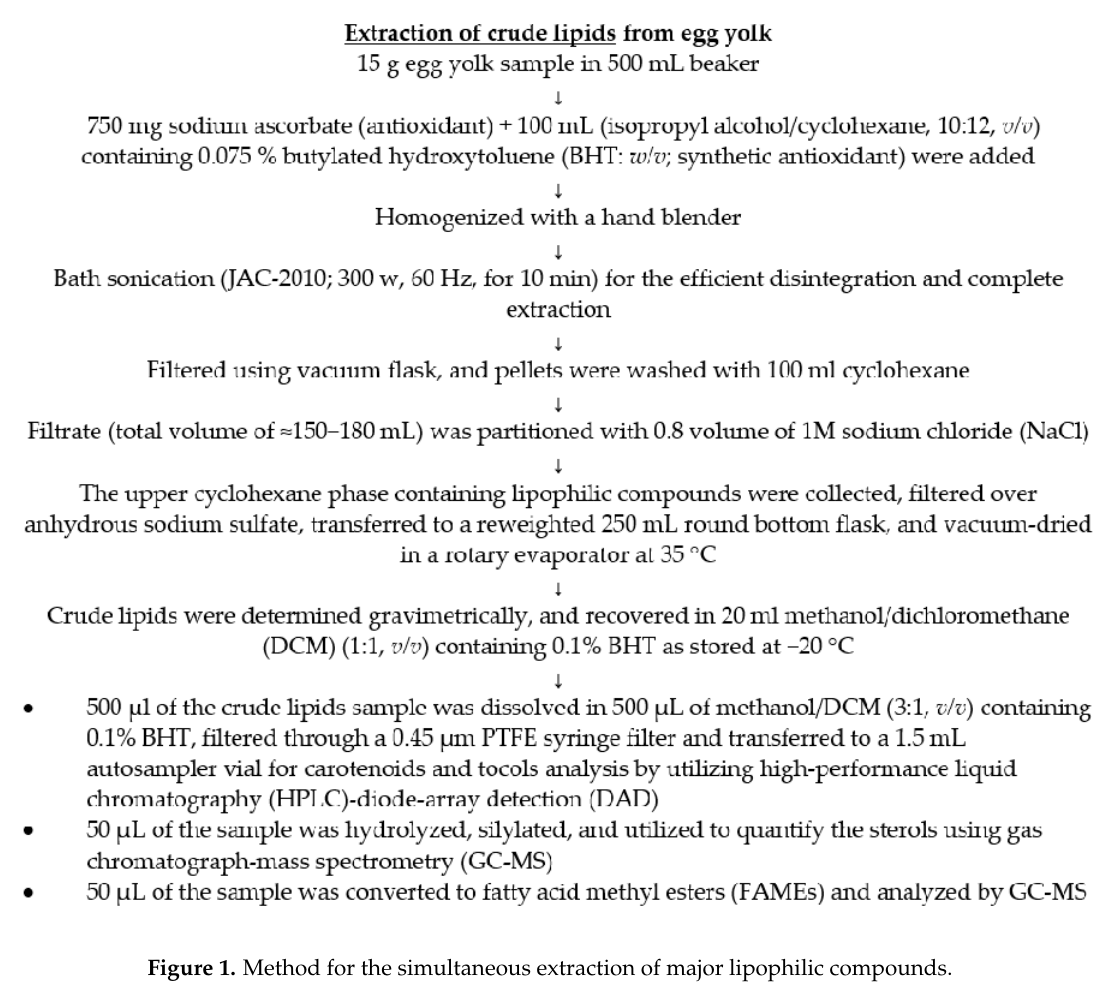
Figure 1. Method for the simultaneous extraction of major lipophilic